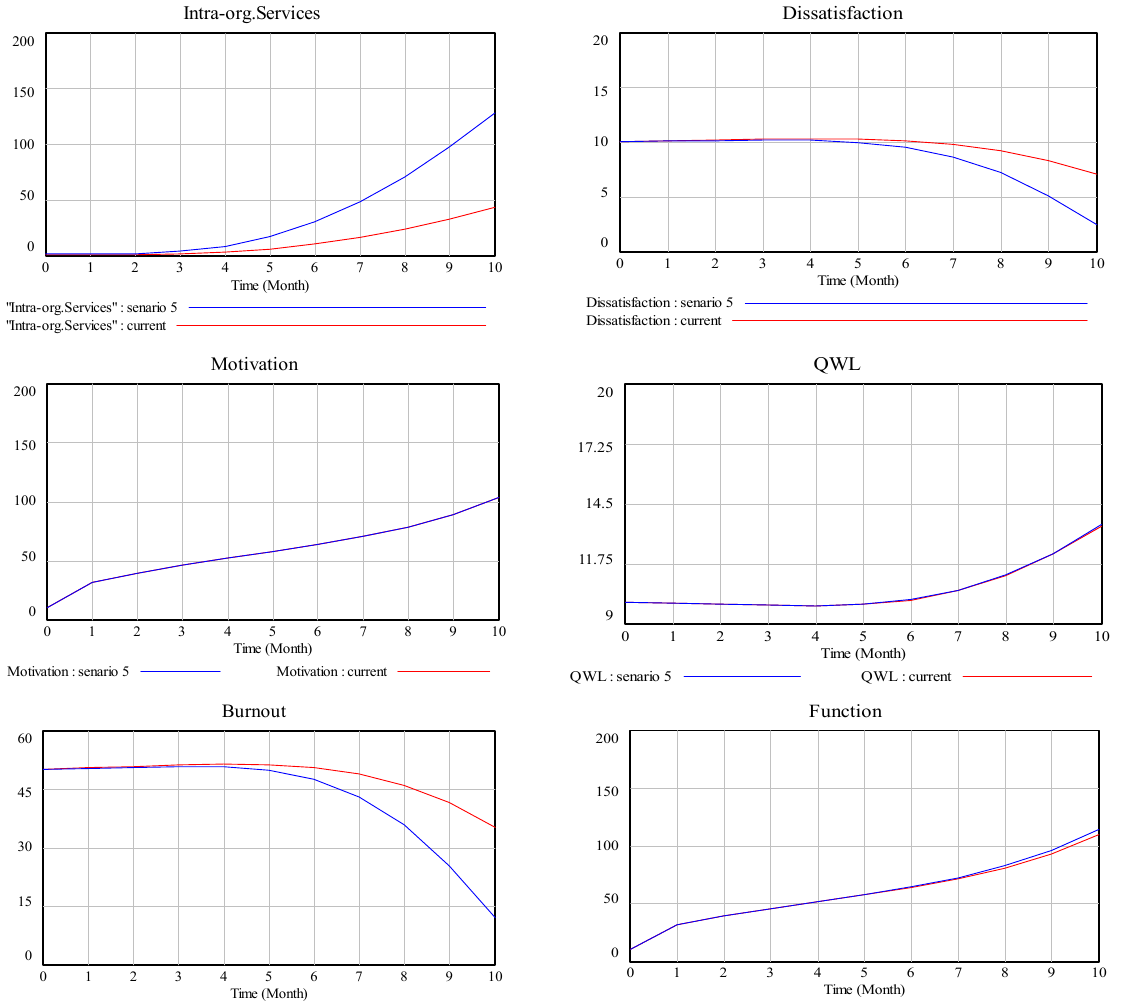
Fig. 9. The improvement impact of intra-organizational services on the variables of the dynamic systems model